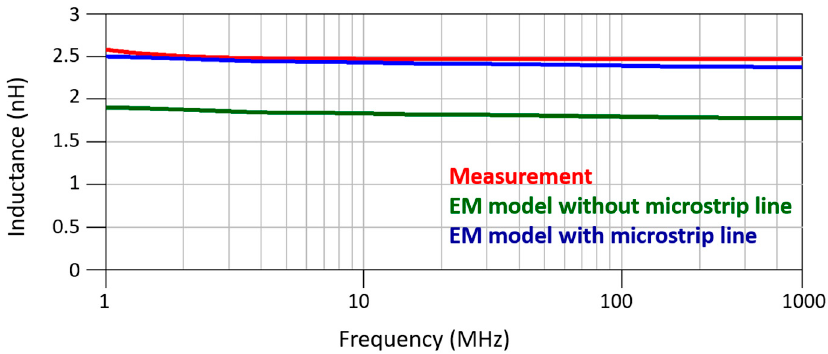
Figure 14. Comparison between experimental drain–source inductance and EM modeling.